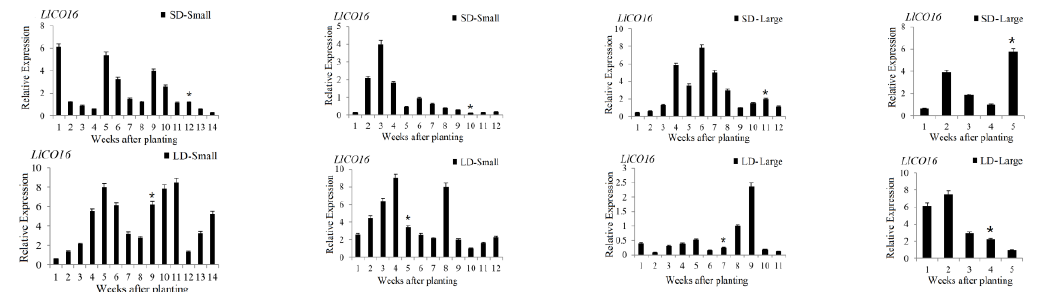
Figure 4. The expression patterns of LlFKF1 , LlGI and LlCOLs in leaves of Lilium longiflorum grown under SD/LD conditions. Notes: These abbreviations are the same as above. * visible buds appeared time after planting.